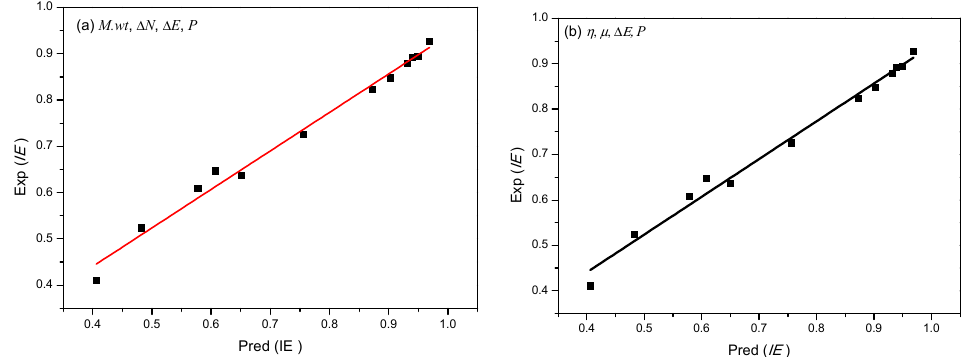
Figure 11. Nonlinear correlation between the predicted inhibition efficiency pred( IE ) obtained by Equation (4) ( a ) and Equation(5), ( b ) and the experimental value exp( IE ) .